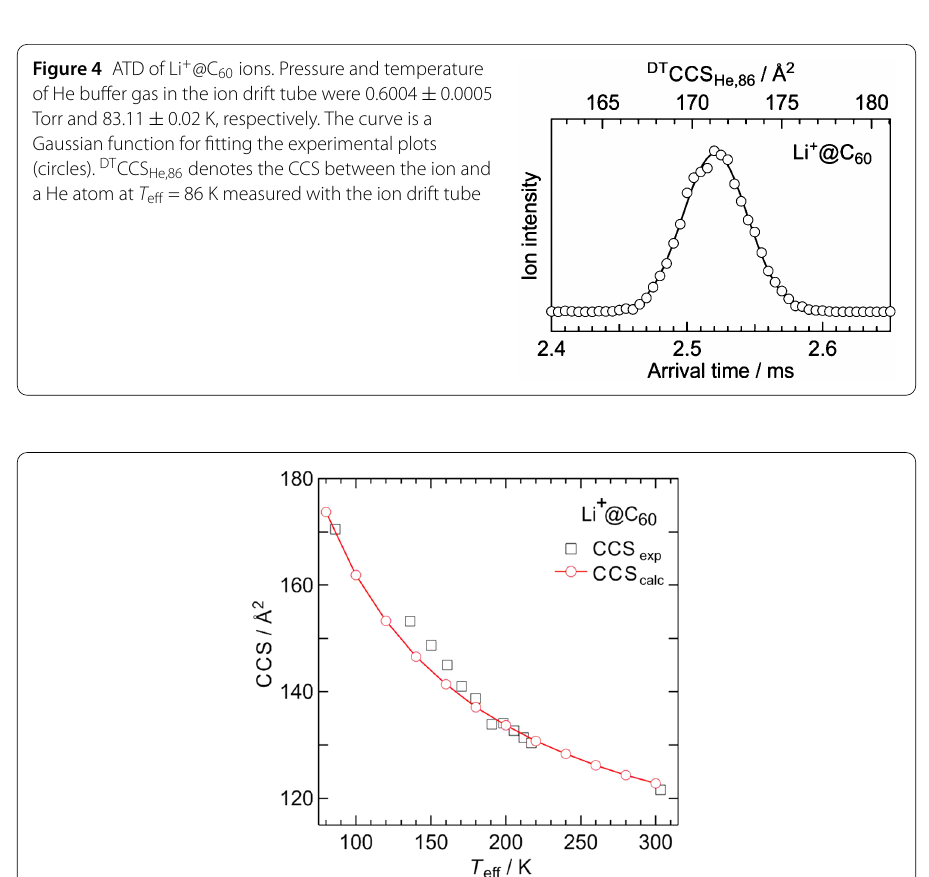
Figure 5 Temperature dependence of CCS of Li + @C 60 with He buffer gas at 80–300 K which was obtained by our measurements and calculations